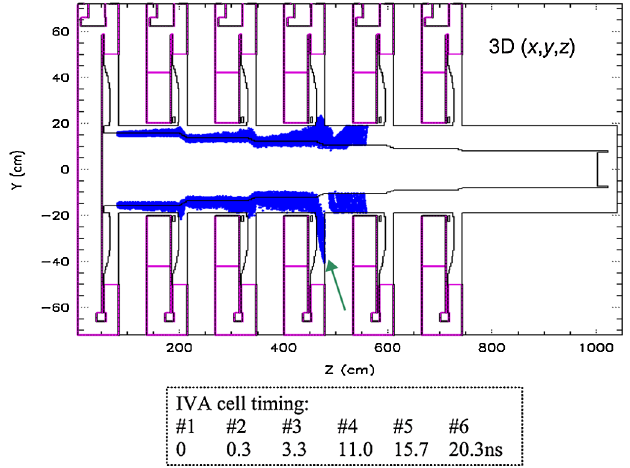
FIG. 8. (Color) Particle snapshot for a simulation with a 7.7 ns delay between the firings of cells 3 and 4 taken just before IVA cell 4 fires. A green arrow indicates electron macroparticles at very large radius in the cavity of cell 4. Electron flow asymme- tries are due to pulse asymmetries in the MITL.